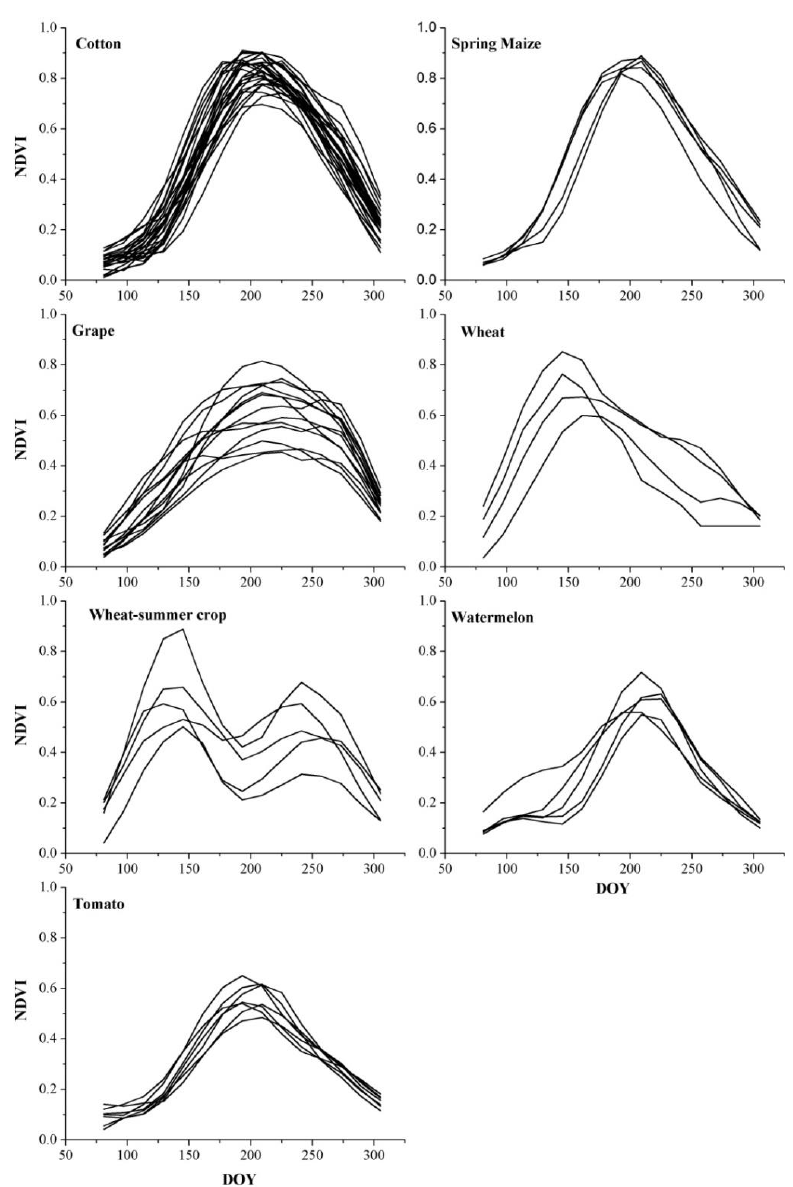
Figure 7. Reference NDVI time series for crops in the study area.